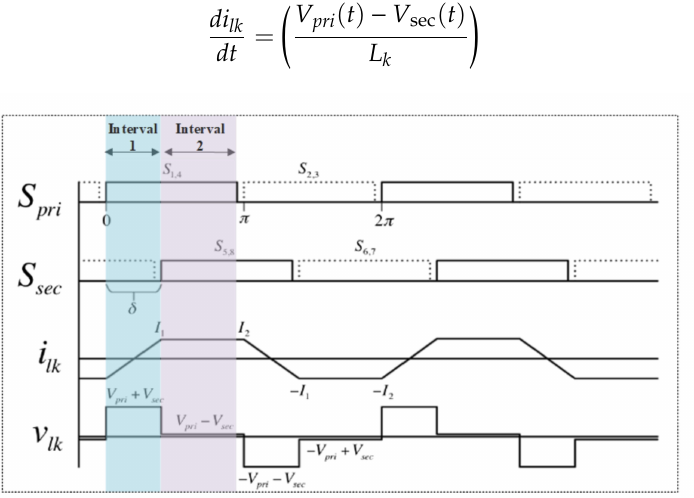
Figure 3. Key waveforms of a DAB